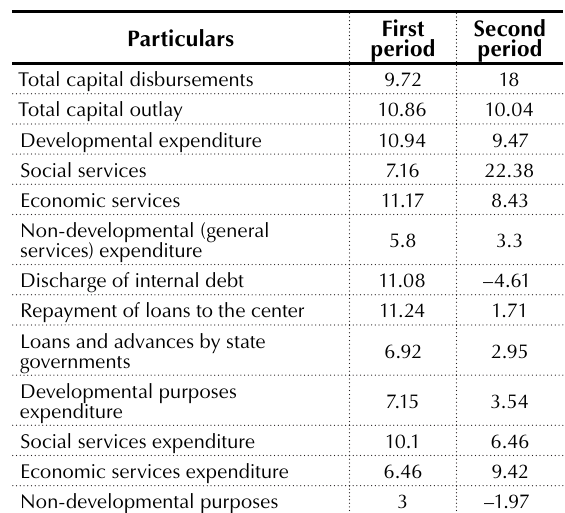
Table 4. Capital expenditure of the state government (CAGR)